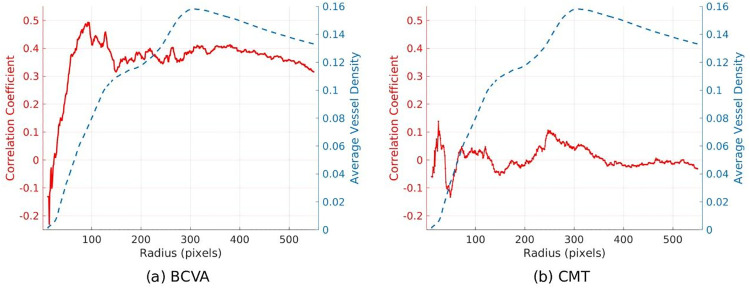
Average vessel density and correlation with best corrected visual acuity (BCVA) and central retinal thickness (CRT) for circular regions with varying radii. Vessel density shows correlation with BCVA but not with CRT.A. Plot of correlation coefficients of BCVA (solid red line) with vessel density (dashed blue line) computed from circular pixel regions with radii ranging from 10 to 550 pixels centered on the fovea. There were significant positive correlations between vessel density and BCVA for radii larger than 53 pixels (p<0.05). B. Plot of correlation coefficients of CRT (solid red line) with vessel density (dashed blue line) computed from circular pixel regions with radii ranging from 10 to 550 pixels centered on the fovea. No significant correlation was found between vessel density and CRT for any radii.